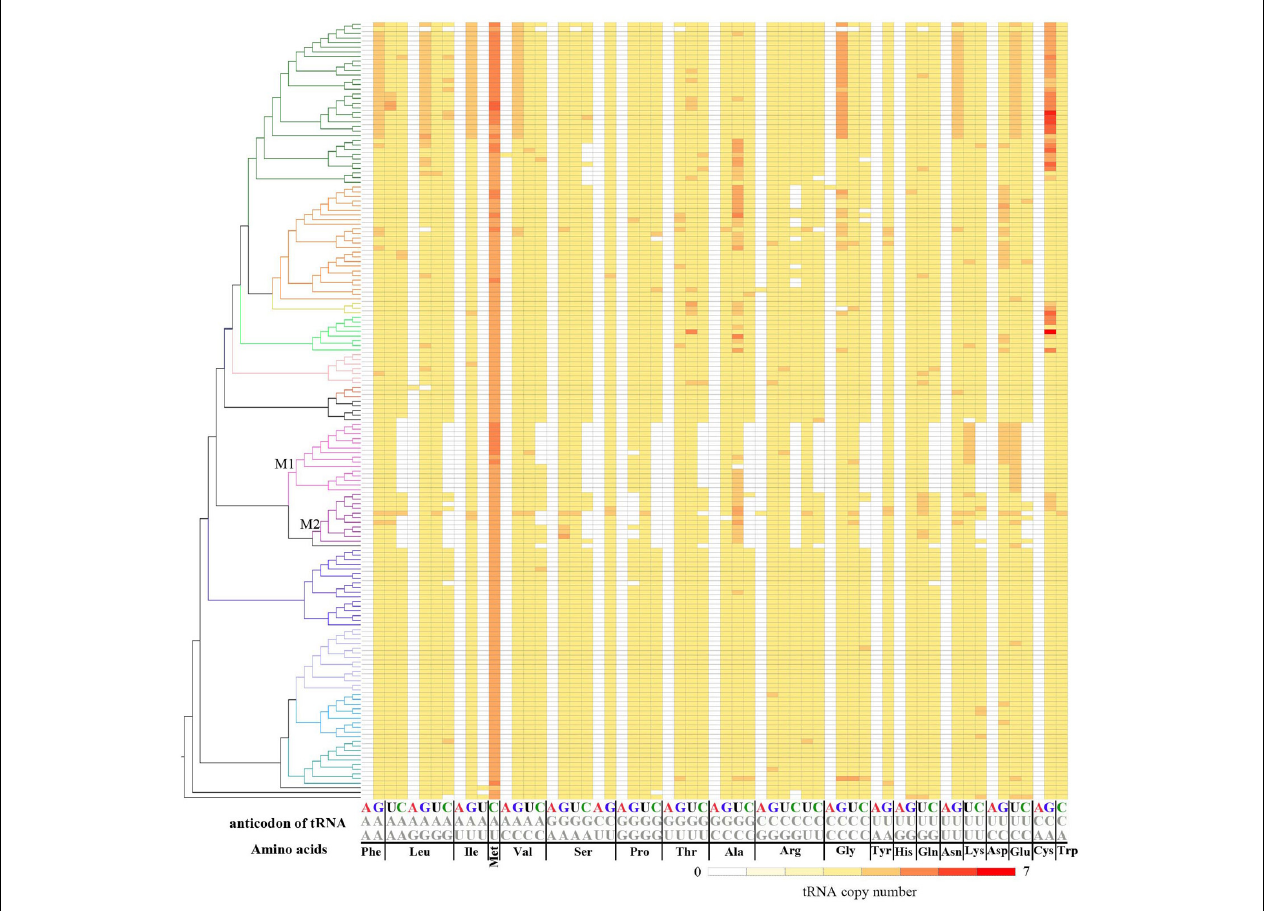
FIGURE 4 | Phylogenetic distribution of different tRNAs in 167 archaeal genomes. The left side of the figure shows a phylogenetic tree of 167 Archaea ( Supplementary Figure S1 ), while the right side is copy numbers for tRNA types (column) in studied genomes (row). The column name indicates amino acids and anticodons. Red indicates more tRNA copies and white indicates no corresponding tRNA copies. More details about tRNA number can be found in Supplementary Table S2 . M1 indicates Methanococcales, and M2 indicates the clade for